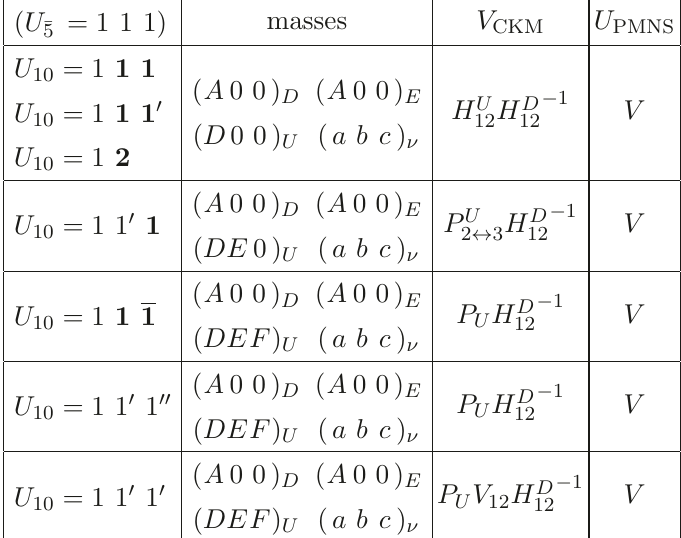
is trivial in all cases. The form 5